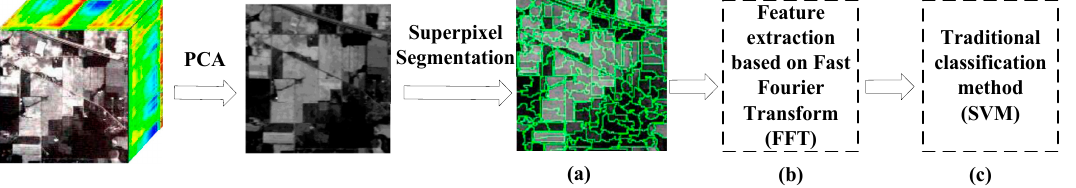
Figure 1. Flow field diagram of general algorithm. ( a ) The result of superpixel segmentation. ( b ) FFT. ( c ) SVM.